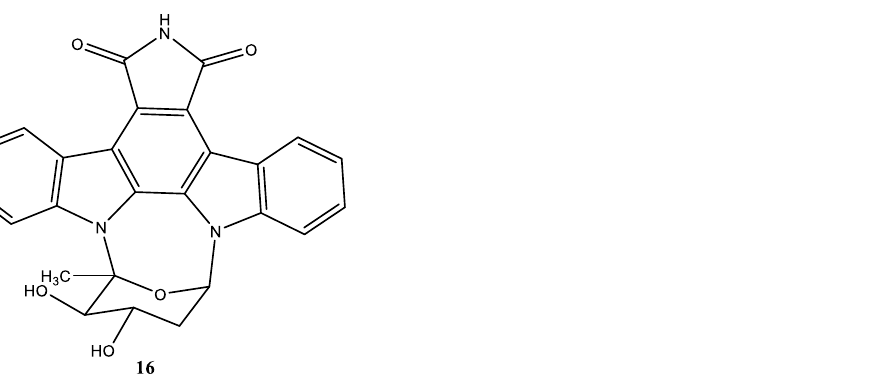
Figure 11. Structure of (5 R ,7 S ,9 S )-7,8-dihydroxy-9-methyl-6,7,8,9-tetrahydro-5 H ,14 H -17-oxa- 4b,9a,15-triaza-5,9-methanodibenzo[b,h]cyclonona[jkl]cyclopenta[e]-as-indacene-14,16(15 H )-dione (EC-70124, 16 ).